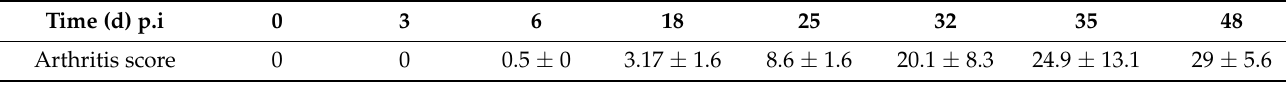
Table 1. Arthitis score during course of collagen-induced arthritis. Time (d)